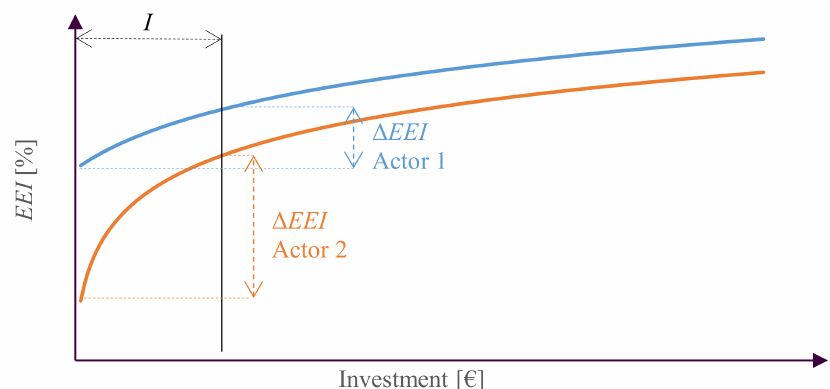
Figure 2. Effect on the Energy Efficiency Index ( EEI ) of the same investment amount I for different actors, which presents different initial EEI and different learning